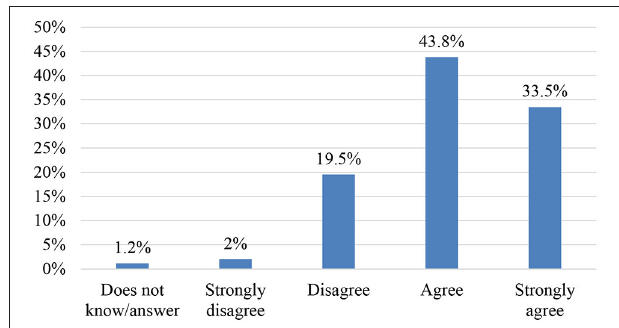
FIGURE 10 | Item 28. Giving the commentator the freedom to design an argumentation guide.